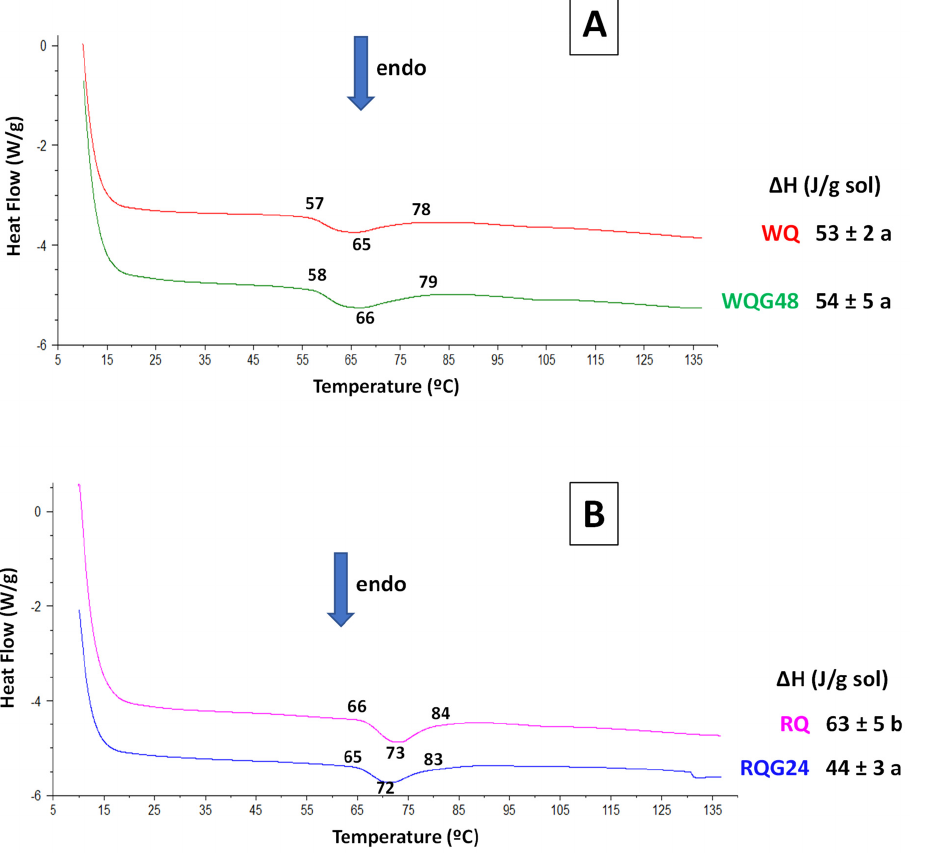
Figure 3. DSC thermograms of the different suspension of quinoa flours: ( A ) WQ: white quinoa, WQG48: germinated 48 h. ( B ) RQ: red quinoa, and RQG24: germinated 24 h. Values of temperatures and enthalpy change of the endothermic process ( Δ H) are shown.